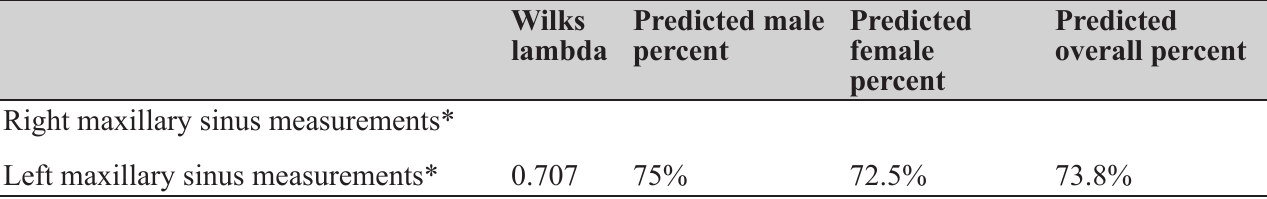
Right maxillary sinus measurements* Left maxillary sinus measurements* *Right maxillary sinus measurements include length, width, height and volume. *Left maxillary sinus measurements include length, width, height and volume. Table 5. Discriminant analysis using both right and left maxillary sinus measurements to distinguish between males and females